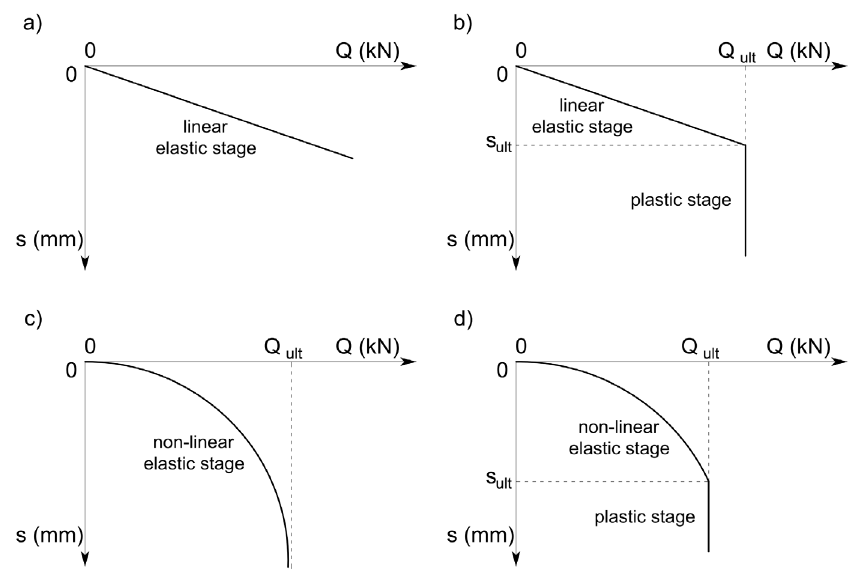
Figure 1: Theoretical model of pile and soil interaction: a) perfectly elastic; b) linear elastic and plastic; c) non-linear elastic; d) non-linear elastic with plastic